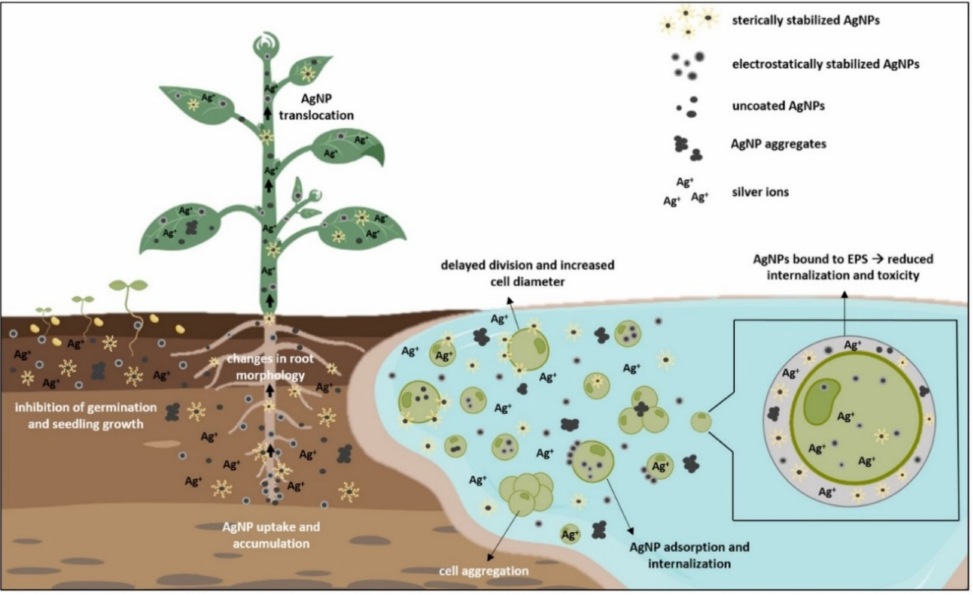
Figure 2. Uptake of differently coated and uncoated AgNPs in plants and freshwater algae and their effects on growth and morphology. EPS—extracellular polymeric substances. Figure was created with BioRender.com. Accessed on 24 November